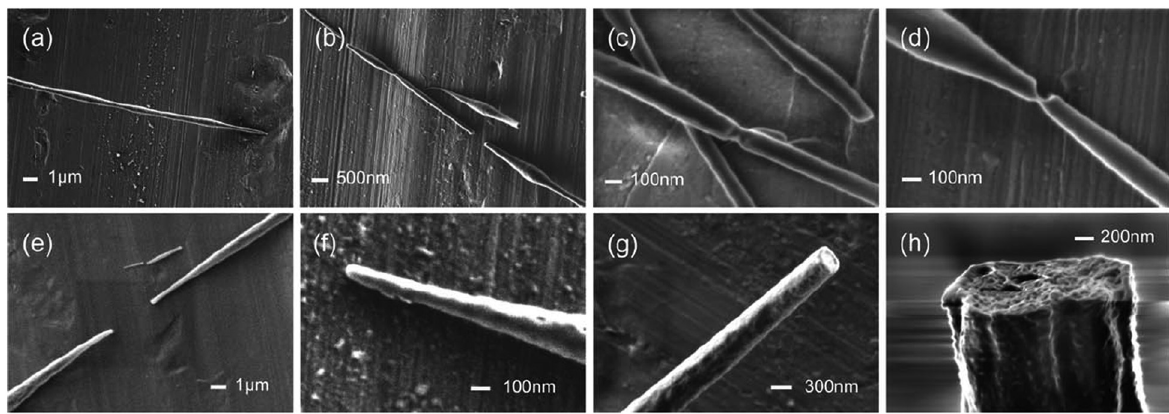
Figure 6: ( a ) Diameter variation; ( b ) fragment; ( c ) neck production; ( d ) breaking; ( e ) individual fragments; ( f ) round end; ( g ) fractured face; and ( h ) fractured cross - section [ 41 ] ; Copyright 2013, reproduced with permission from John Wiley and